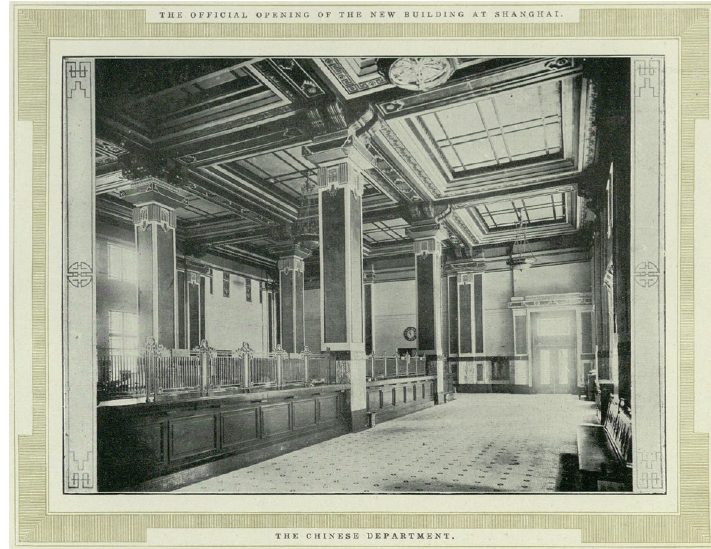
Fig. 4 The Chinese Banking Hall from the original pamphlet of the opening ceremony of the HSBC Bank in 1923. (Source: “The Hong Kong and Shanghai Banking Corporation”, 1923. Reproduced with the permission of HSBC Holdings